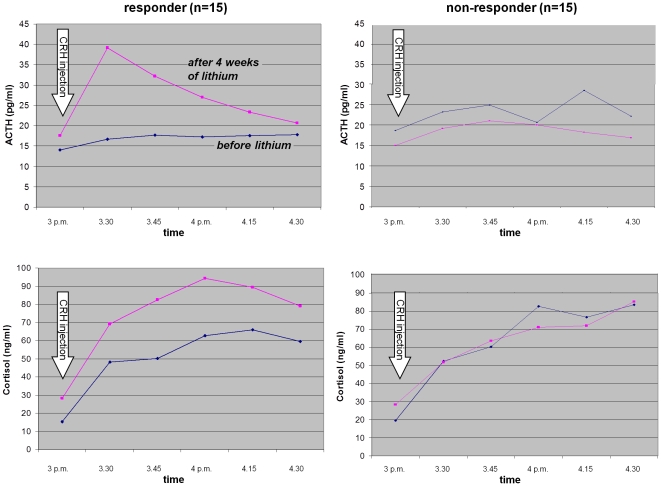
ACTH and cortisol response in the combined DEX/CRH test on the day before lithium monotherapy (blue line) and after four weeks of lithium treatment (pink line) in responders and non-responders (n = 29).